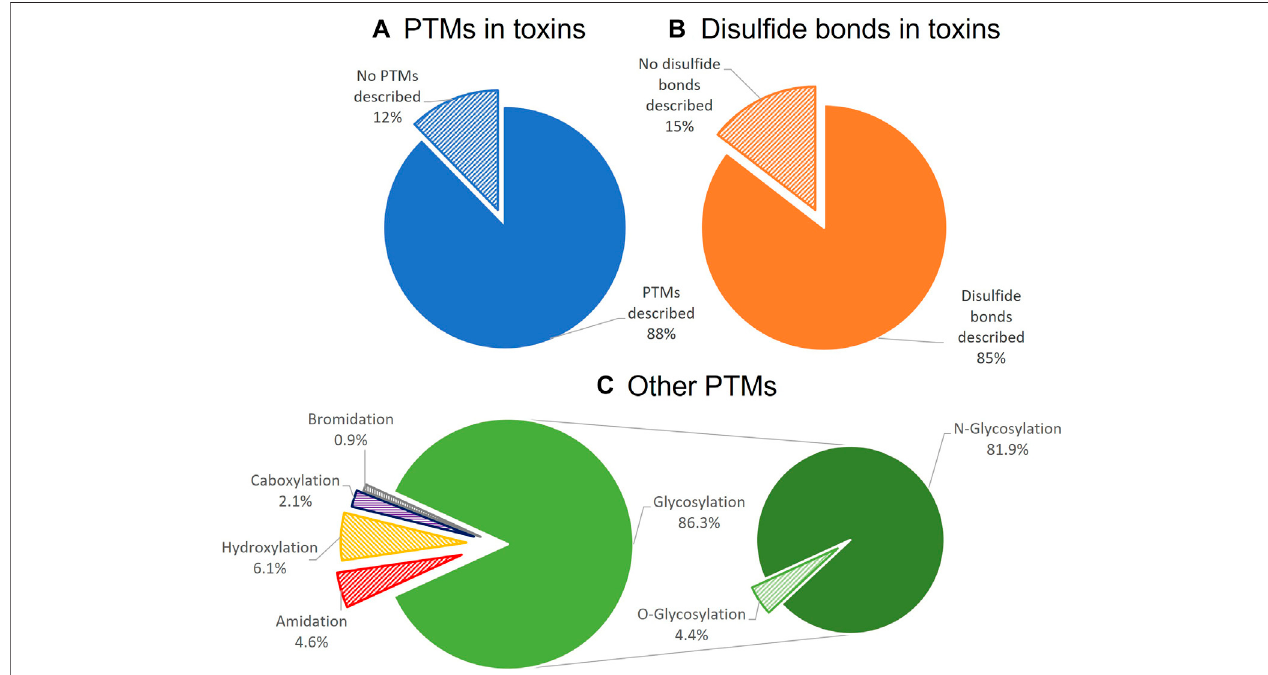
FIGURE2 | Distributionof PTMsamong toxinslisted in Uniprot-Toxprot, the Animal ToxinAnnotation Project. Only 12%of thelisted animal toxinsdo not have any described PTMs (A) . From the toxins with PTMs, 85% had disul fi de bonds (B) . After disul fi de bonds, glycosylation, and especially N-glycosylation, is the most common PTM described for toxins (C)